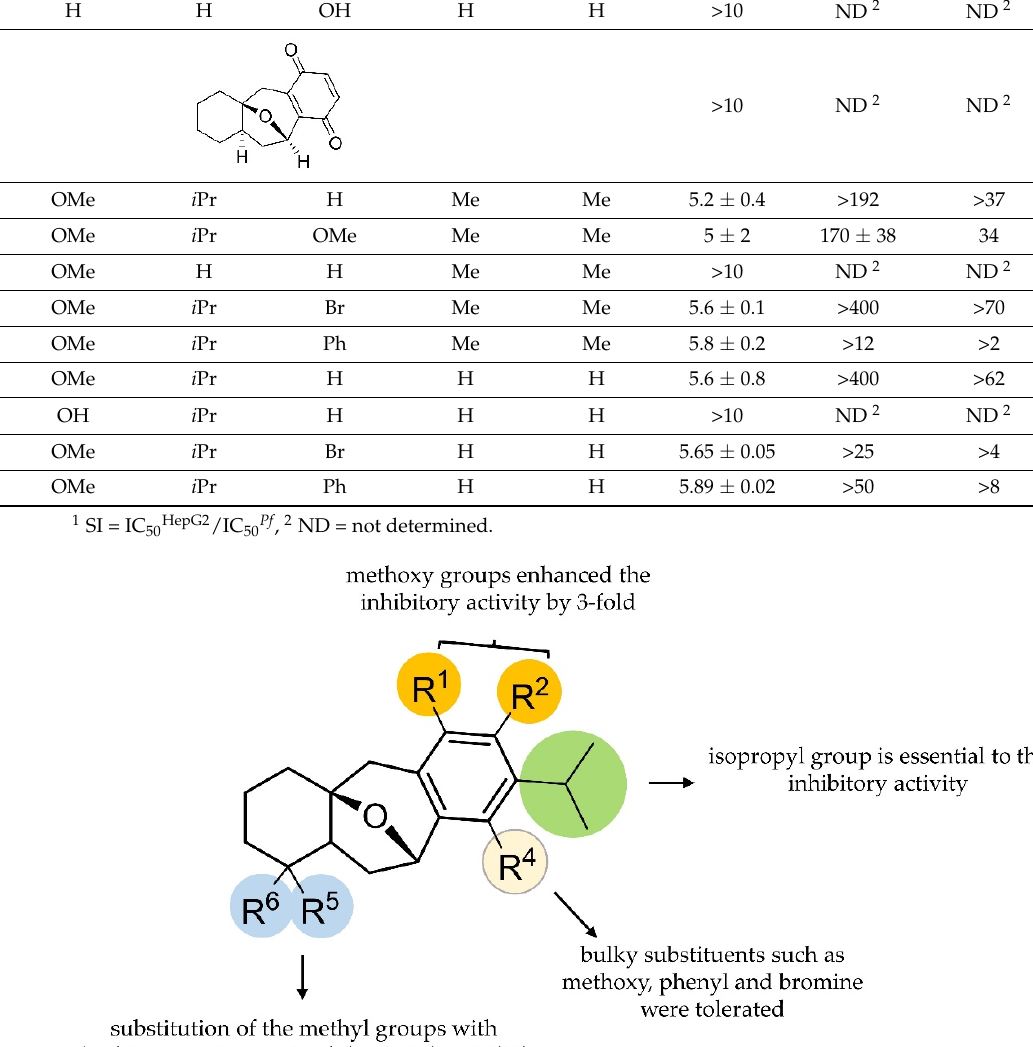
Table 2. IC 50 values of compound brussonol against a panel of sensitive and resistant P. falciparum strains. Figure 3 . SAR summary around the icetexane diterpenoid scaffold.